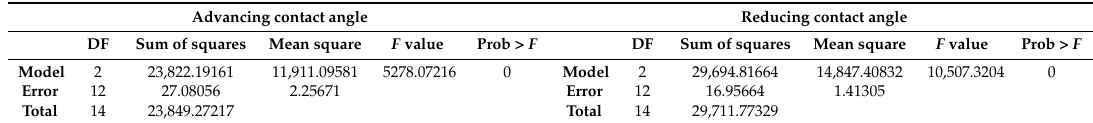
Table 2. Overall analysis of variance for water contact angle.